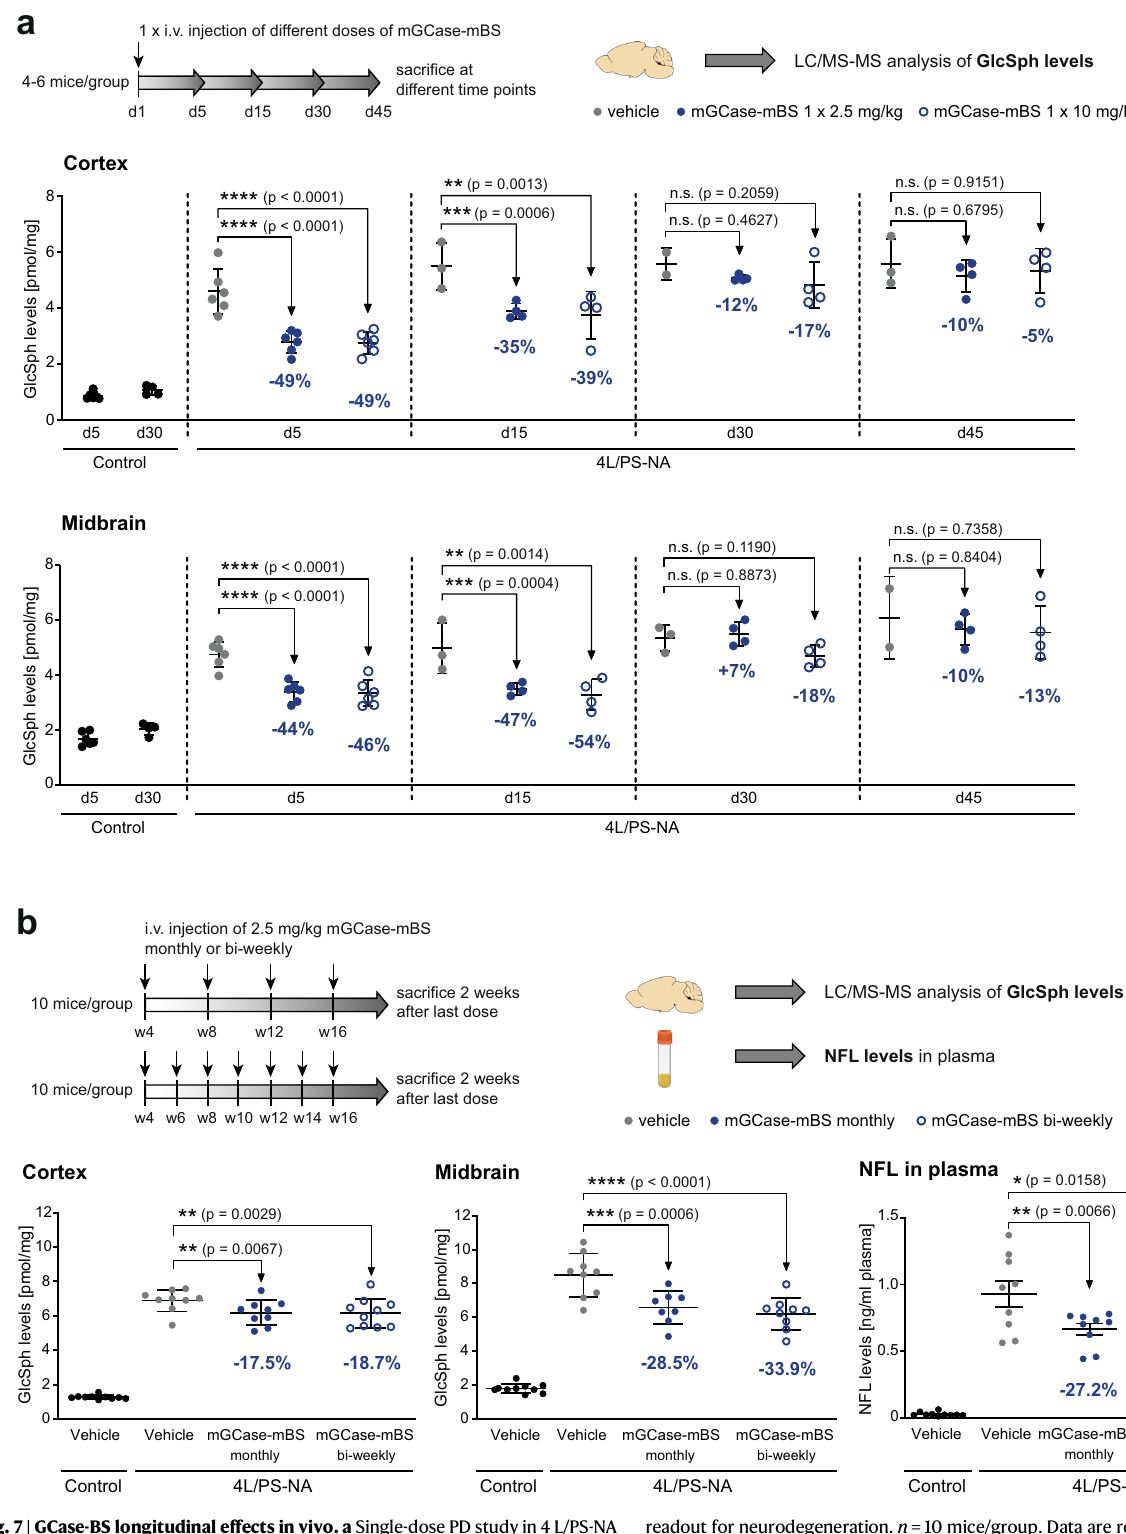
readout for neurodegeneration. n =10 mice/group. Data are represented as group means +/ − SEM. Data was analysed by one-way ANOVA (Dunnett ’ s multiple com- parisons test) comparing eachtreatment group to 4L/PS-NA, vehicle. n.s. p >0.05; * p <0.05; ** p <0.01; *** p <0.001; **** p <0.0001. Source data are provided as a Source Data fi le. Schematics created with